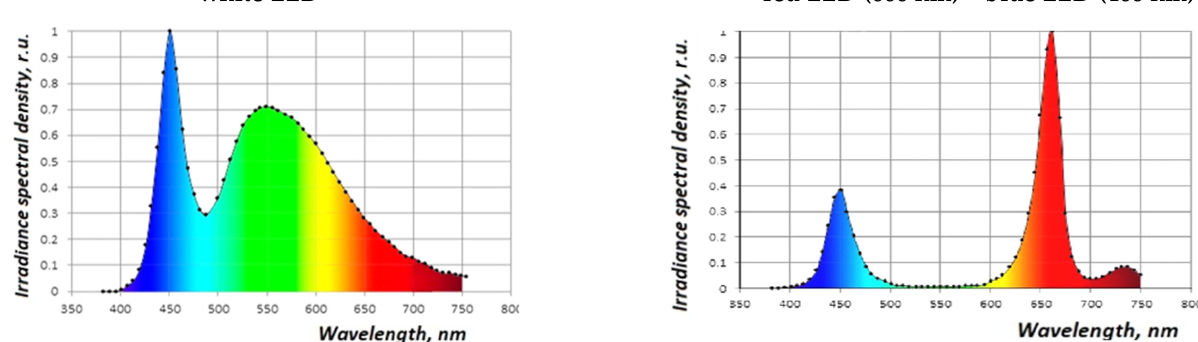
Figure 1. Graphs of LED light spectra used to evaluate the effect of exposure to light of white and red-blue spectra on S. rebaudiana microshoot growth.